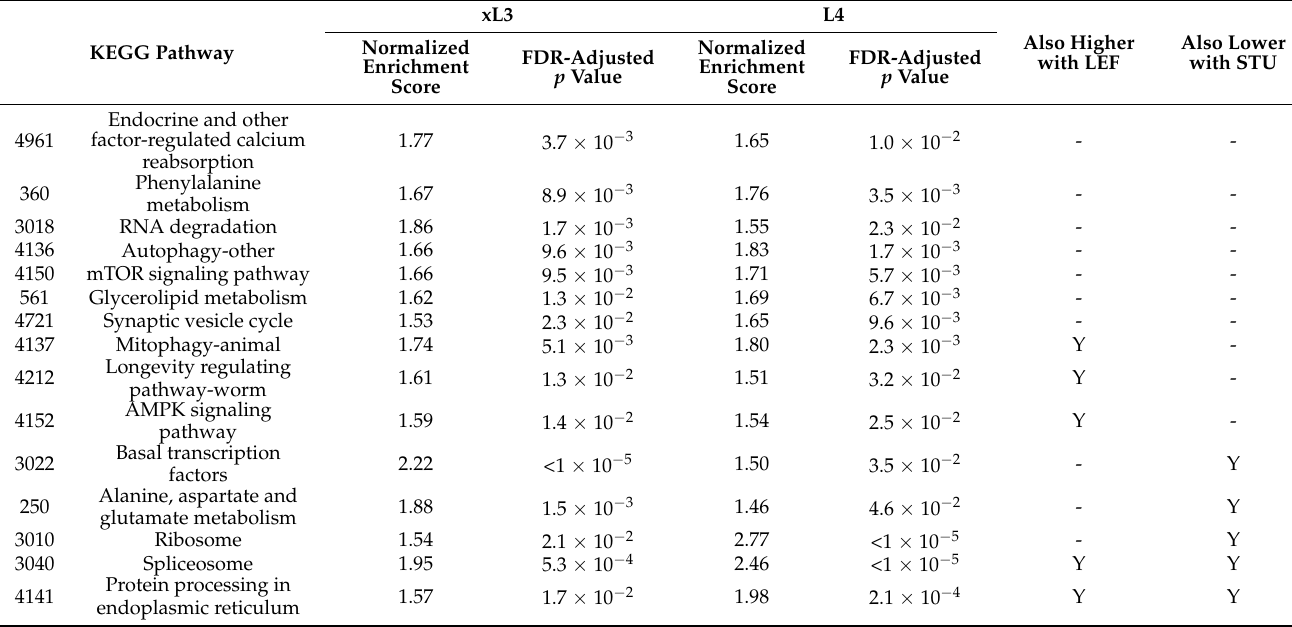
Table 2. Top 15 KEGG pathways most significantly downregulated in both xL3 and L4 H. contortus in response to Leflunomide treatment.